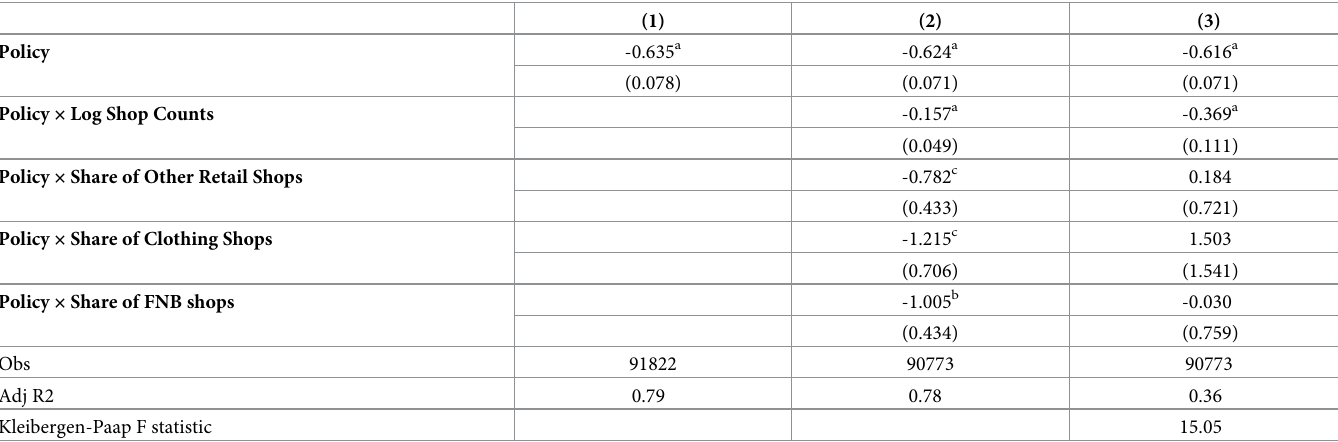
Table 2. The impact of lockdowns on